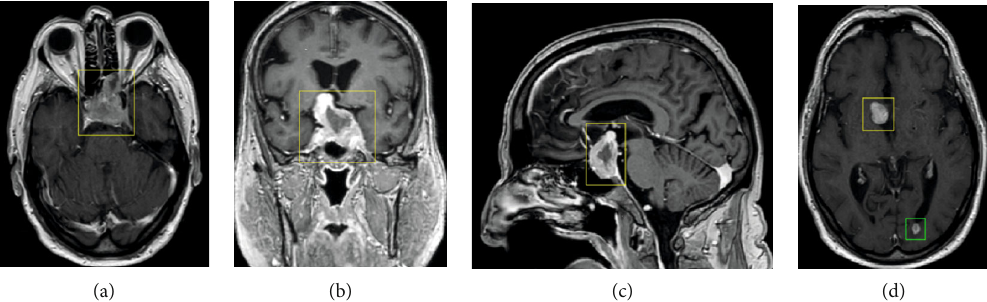
Figure 2: Radiographic imaging of tumor progression preoperatively. T1-weighted sequence magnetic resonance imaging with contrast presented in axial, coronal, sagittal, and axial planes, respectively. Imaging demonstrates growth of the previously described mass with further encasement of the left cavernous internal carotid artery (a) with superior extension (b) with further e ff acement of the third ventricle (c). A subcentimeter-enhancing, spherical, paraventricular, left occipital lesion is apparent (d). The sellar mass now measures 5 : 7 x 3 : 8x4 : 4cm with a total estimated volume of 22.7 mL. Yellow boxes highlight the tumor of interest. Green box highlights an occipital